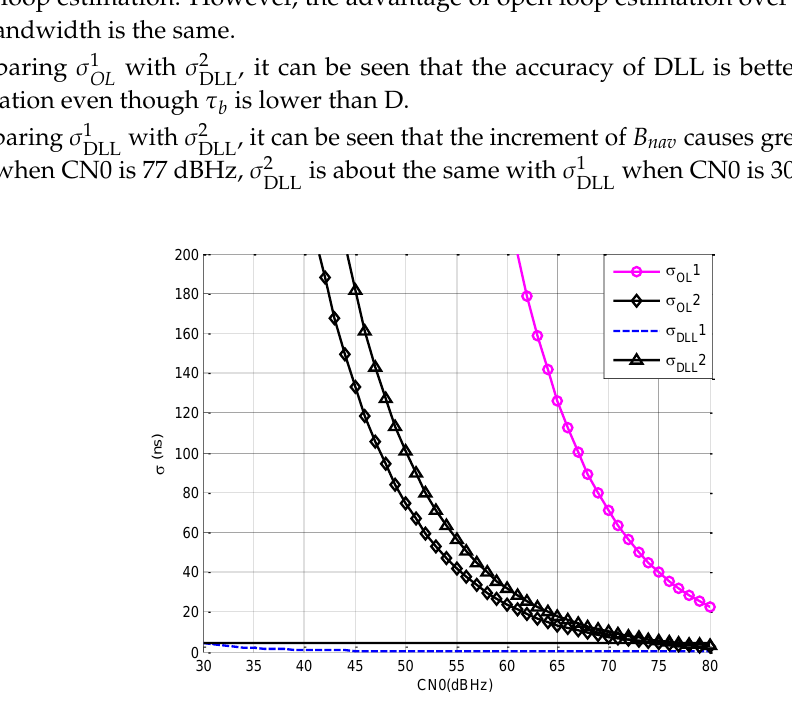
Figure 4. The accuracy of pseudorange versus carrier noise power spectral density rate (CN0).